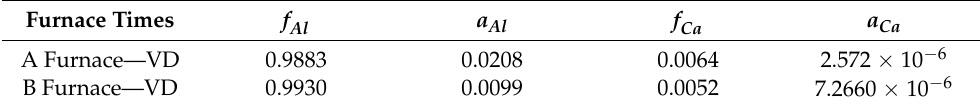
Table 6. The activity coefficient and activity of Ca and Al in calcium treated steel.